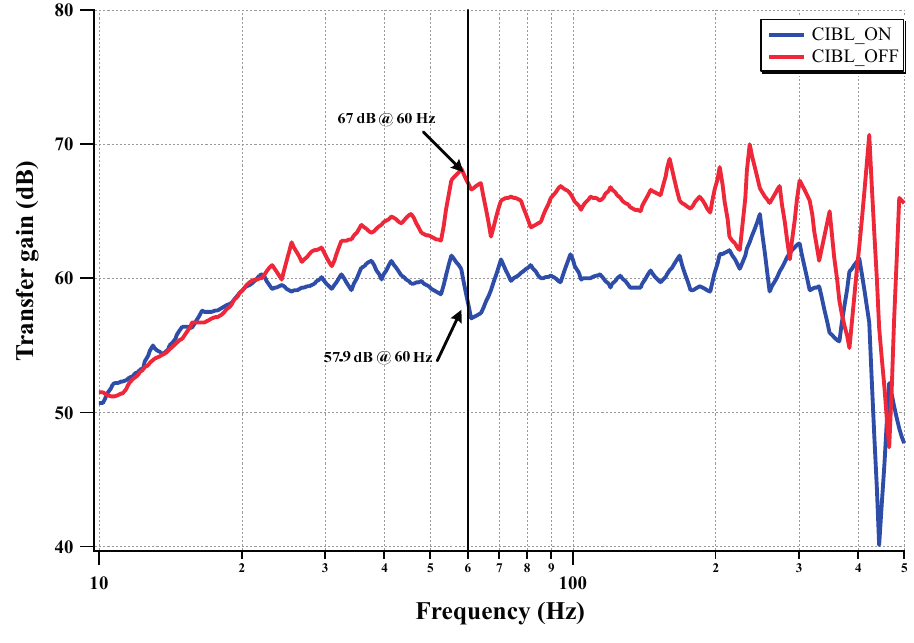
Figure 16. Measured CMRR with the CIBL.